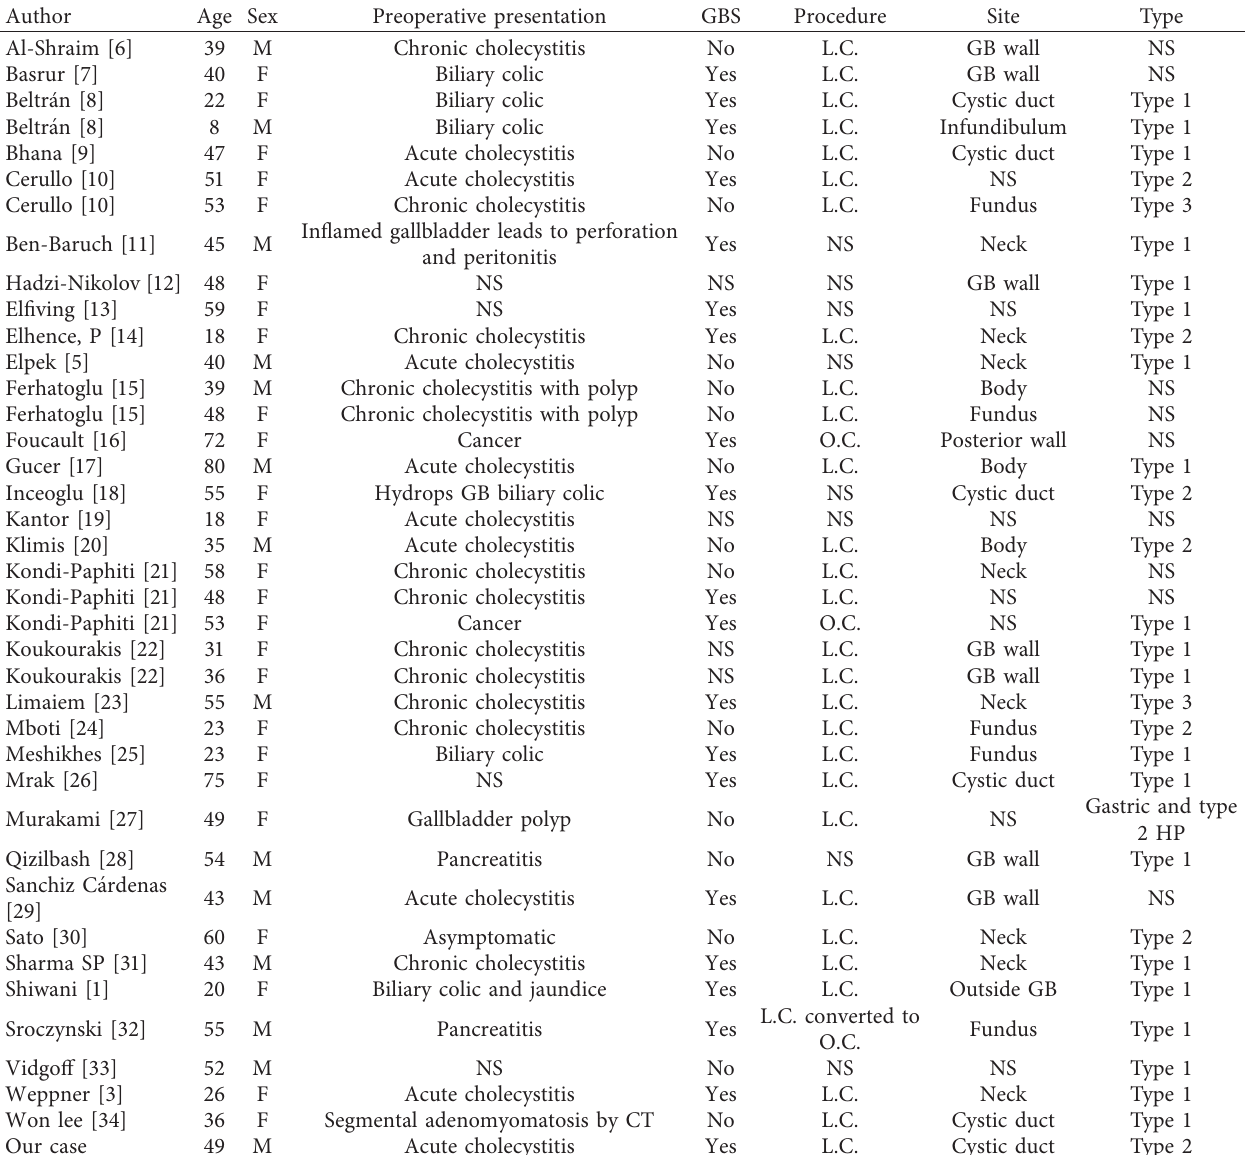
Table 1: Demographic data, clinical presentation, and histopathology of 38 cases of heterotopic pancreas in the gallbladder.